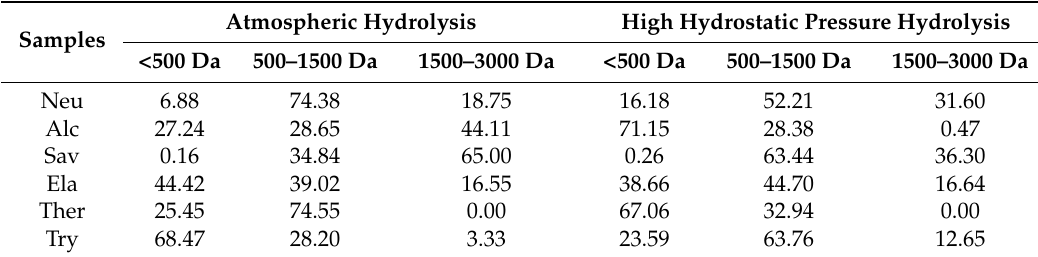
Table 2. The relative area (%) of the peptide peaks obtained in the MALDI-TOF spectra of β -lactoglobulin hydrolysates produced under atmospheric and high hydrostatic pressure conditions.